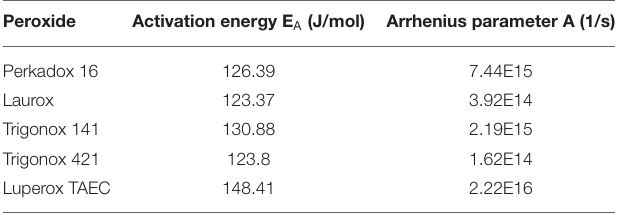
TABLE 3 | Overview on the Arrhenius parameters of the different peroxides used (Nouryon,